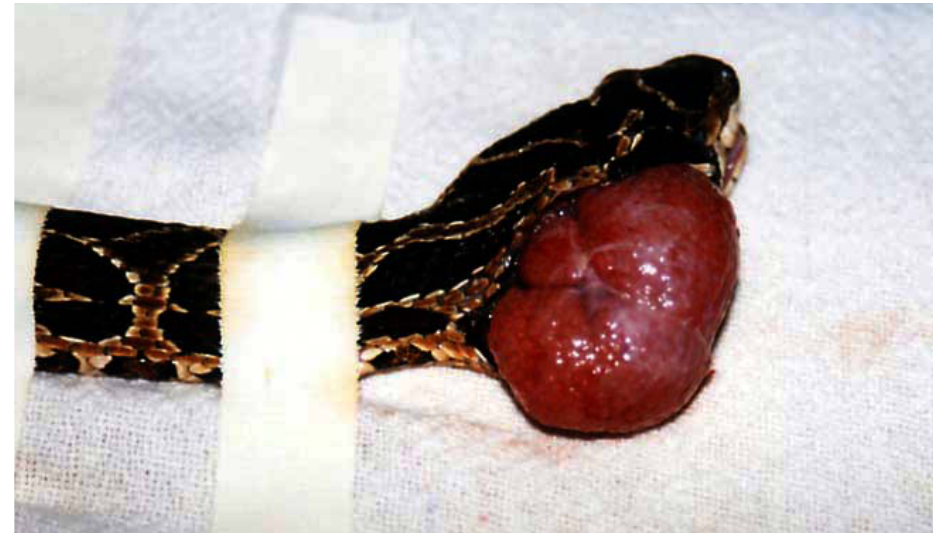
Figure 7. Venom gland tumor in an old Bothrops alternatus